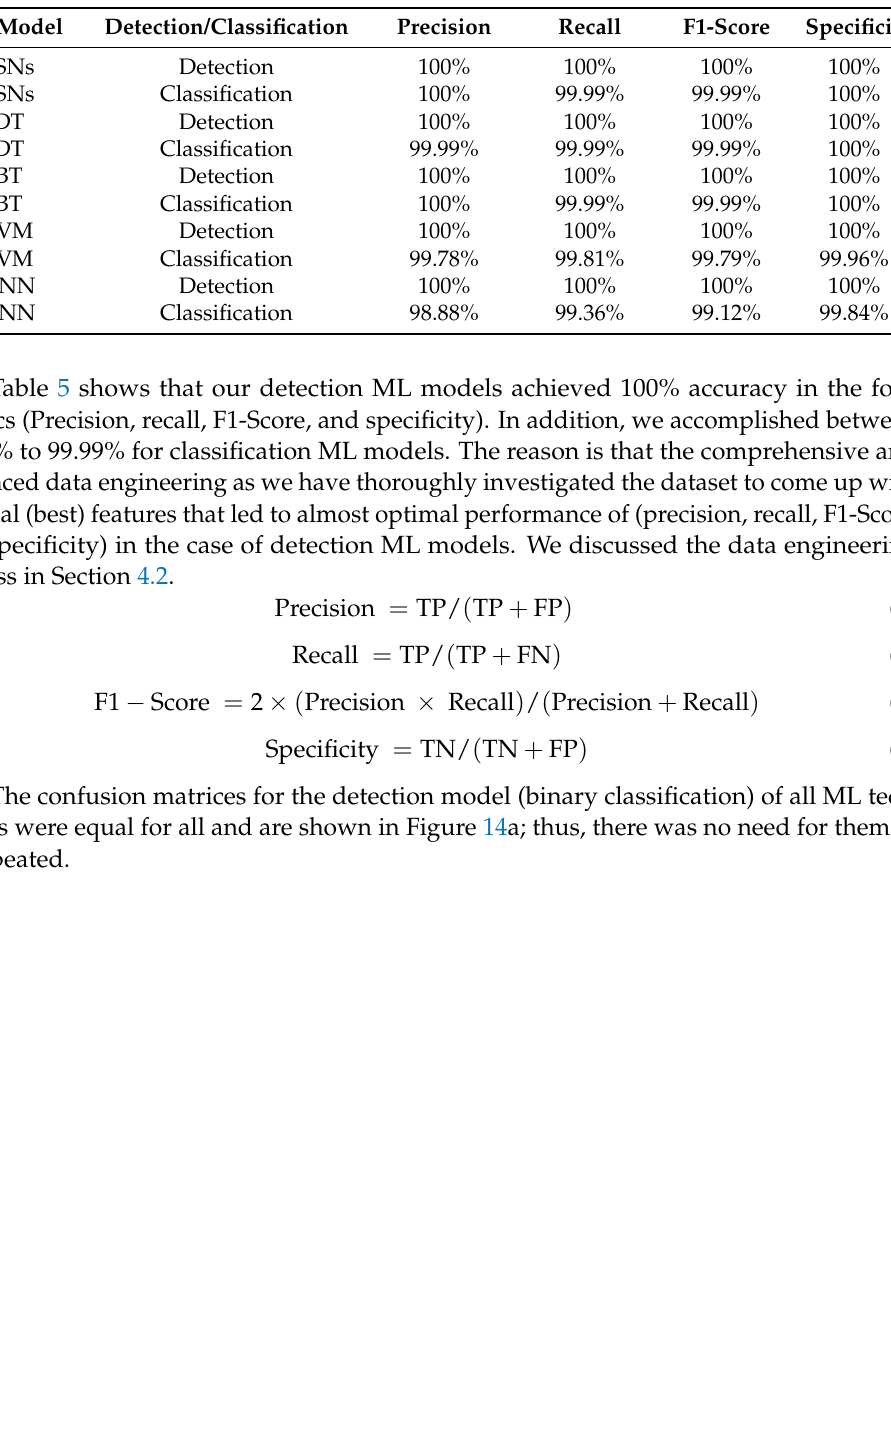
Table 5. Accuracy evaluation